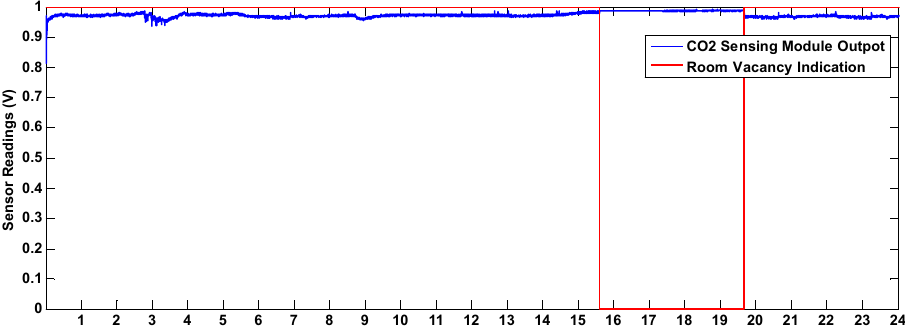
Figure 13. CO2 sensor reading with respect to room occupancy status over 24 h.